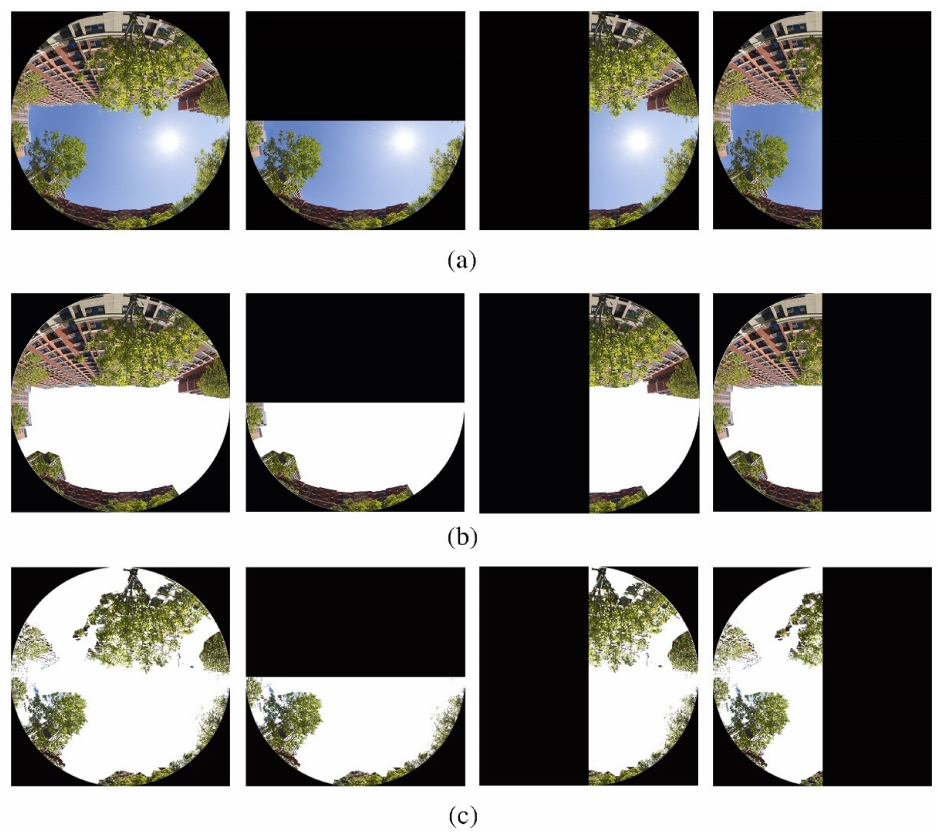
Figure 8. SVF ( a ), SVF A ( b ), SVF G ( c ) fisheye photographs (0–360 ◦ , 90–270 ◦ , 0–180 ◦ , 180–360 ◦